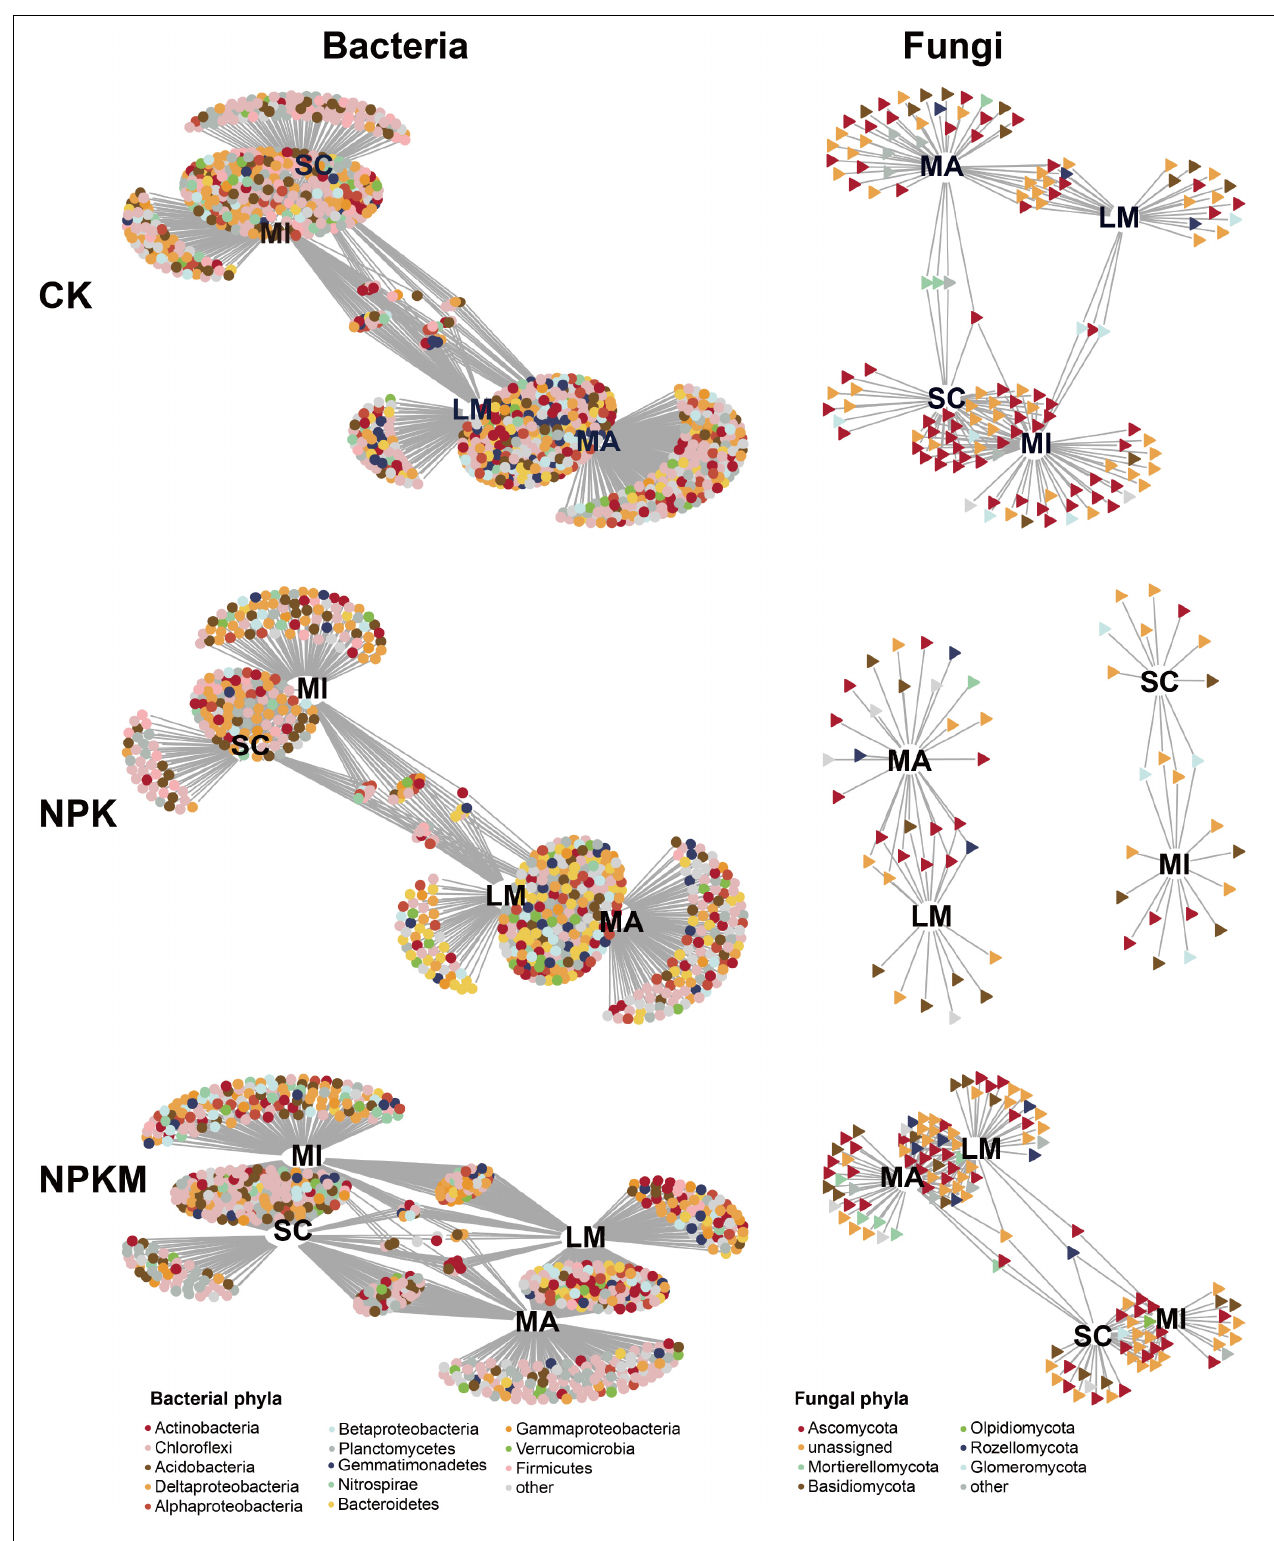
FIGURE 3 | Bipartite networks display soil aggregation specific bacterial and fungal OTUs in different fertilization regimes determined by indicator species analysis. Circles represent bacteria and triangle represent fungi. OTUs are colored according to the phylum assignment. See Figure 1 .